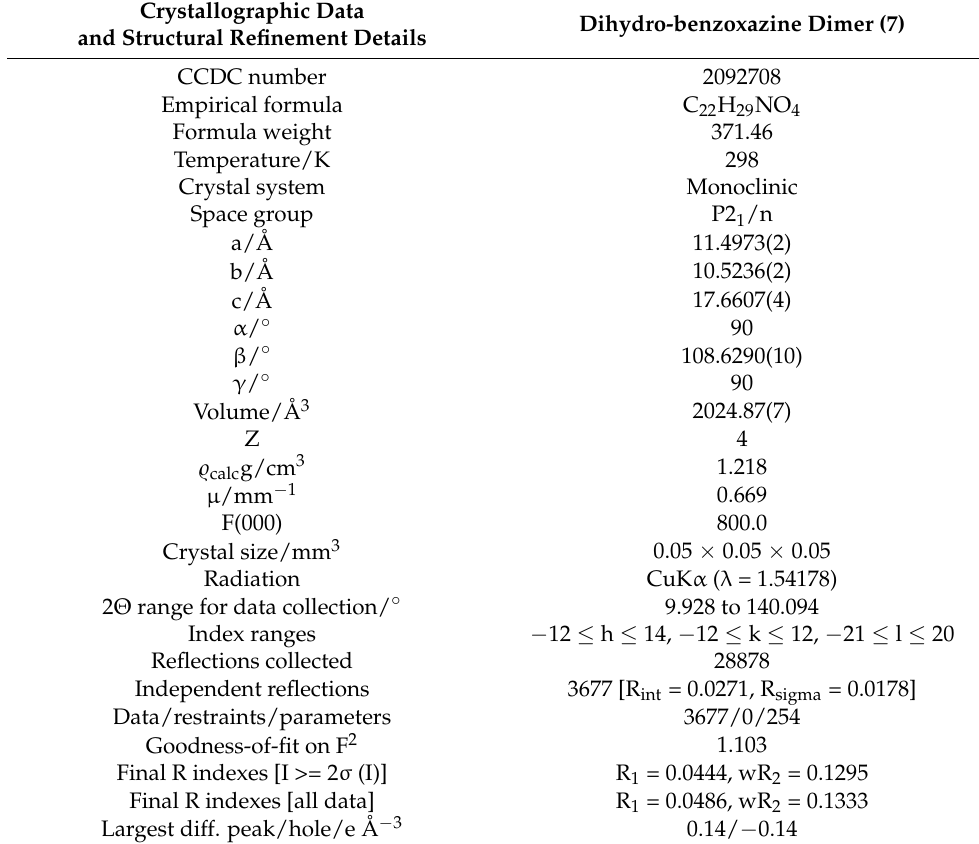
Table 1. Crystallographic data and structure refinement details for the compound